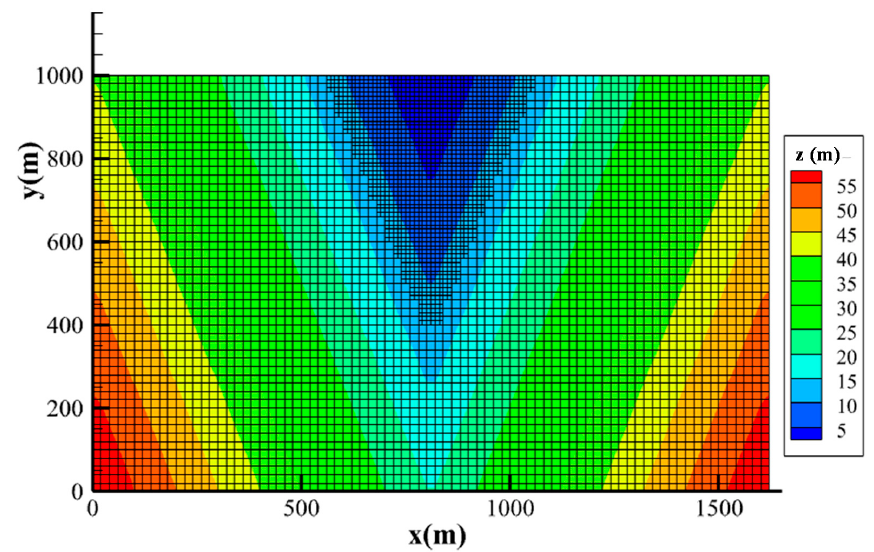
Figure 11. The grid partition of the V-shaped catchment (fully computational domain).